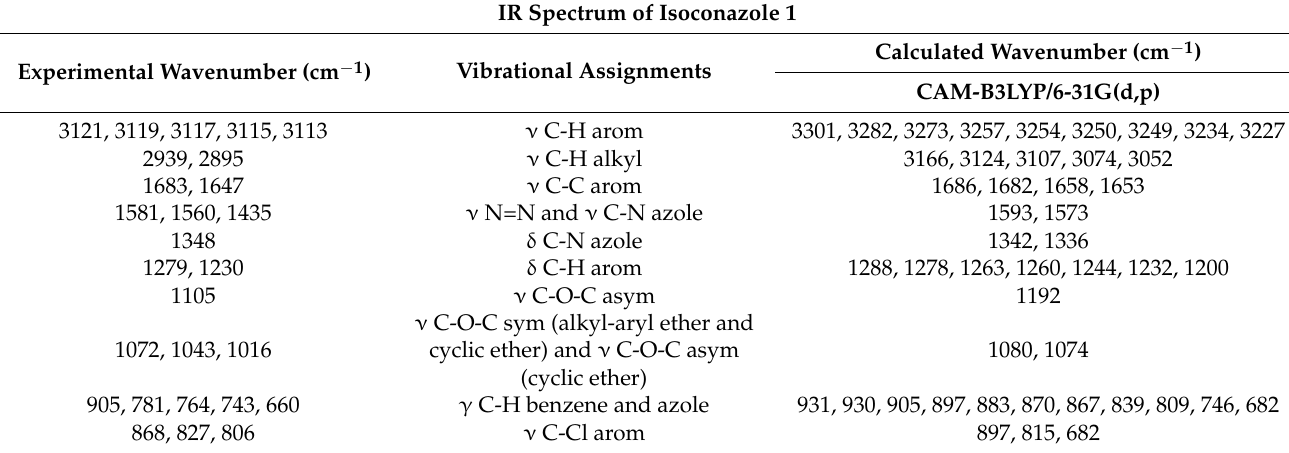
Table 3. IR spectrum of compound 1 ; CAM-B3LYP/6-31G(d,p)/gas level of theory; υ : stretching; δ : in-plane bending; γ : out-of-plane